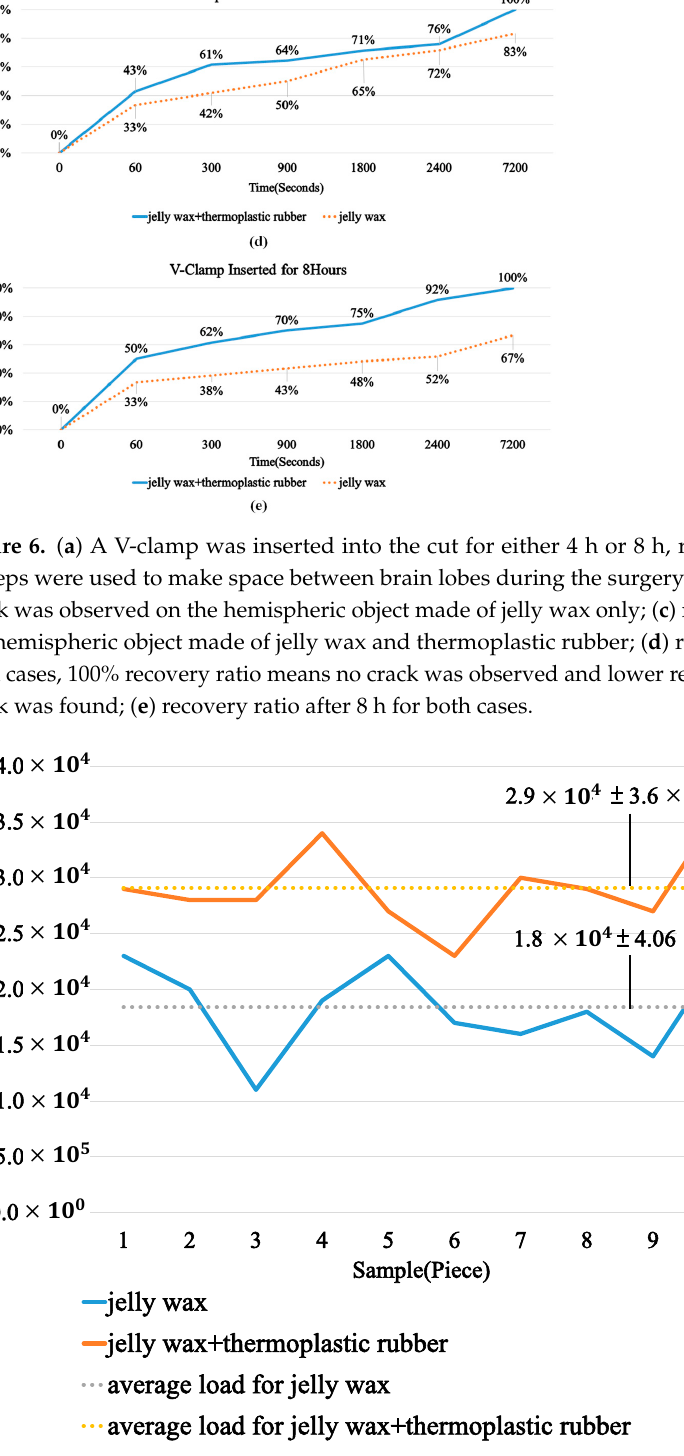
Figure 7. The experimental results of the tensile tests for both materials.